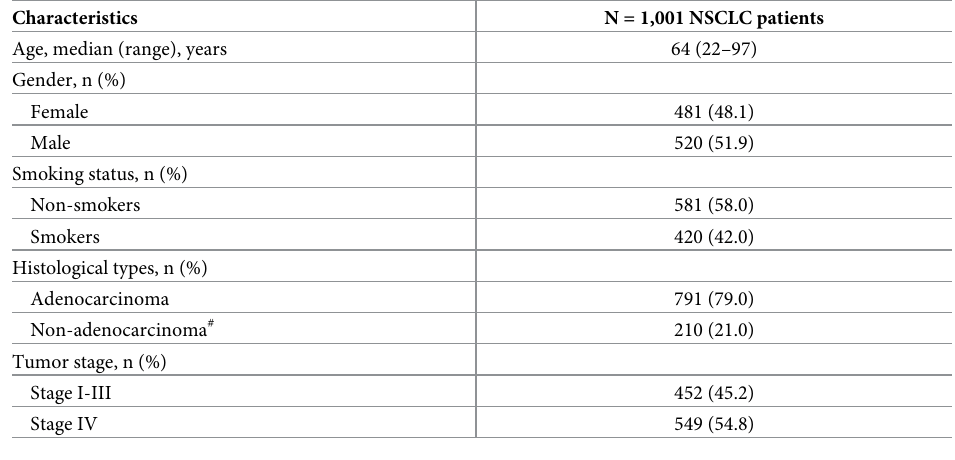
Table 1. Demographic data and patients’ characteristics.